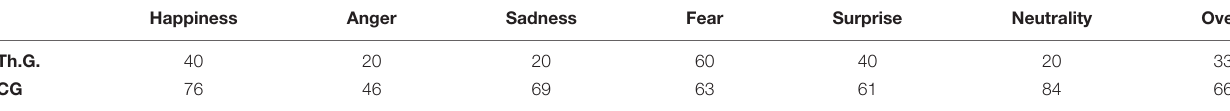
TABLE 1 | Mean percent (%) responses of the control group (CG) and our patient (Th.G.) on the APT. Happiness Anger Sadness Fear Surprise Neutrality Overall